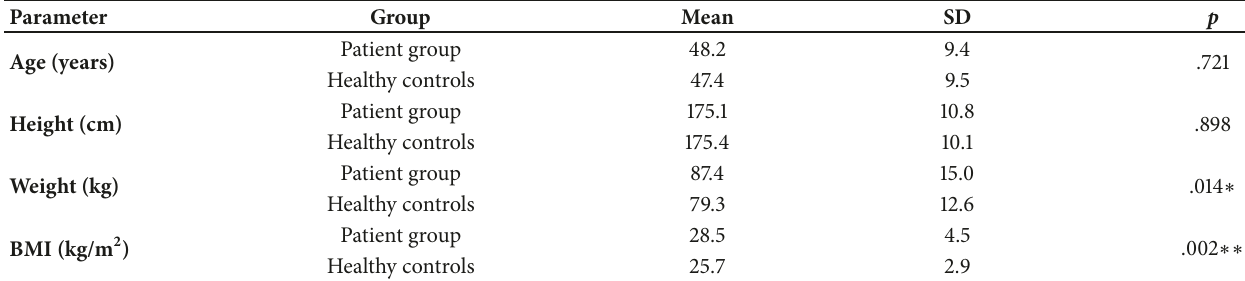
Table 1: Characteristics of participants.